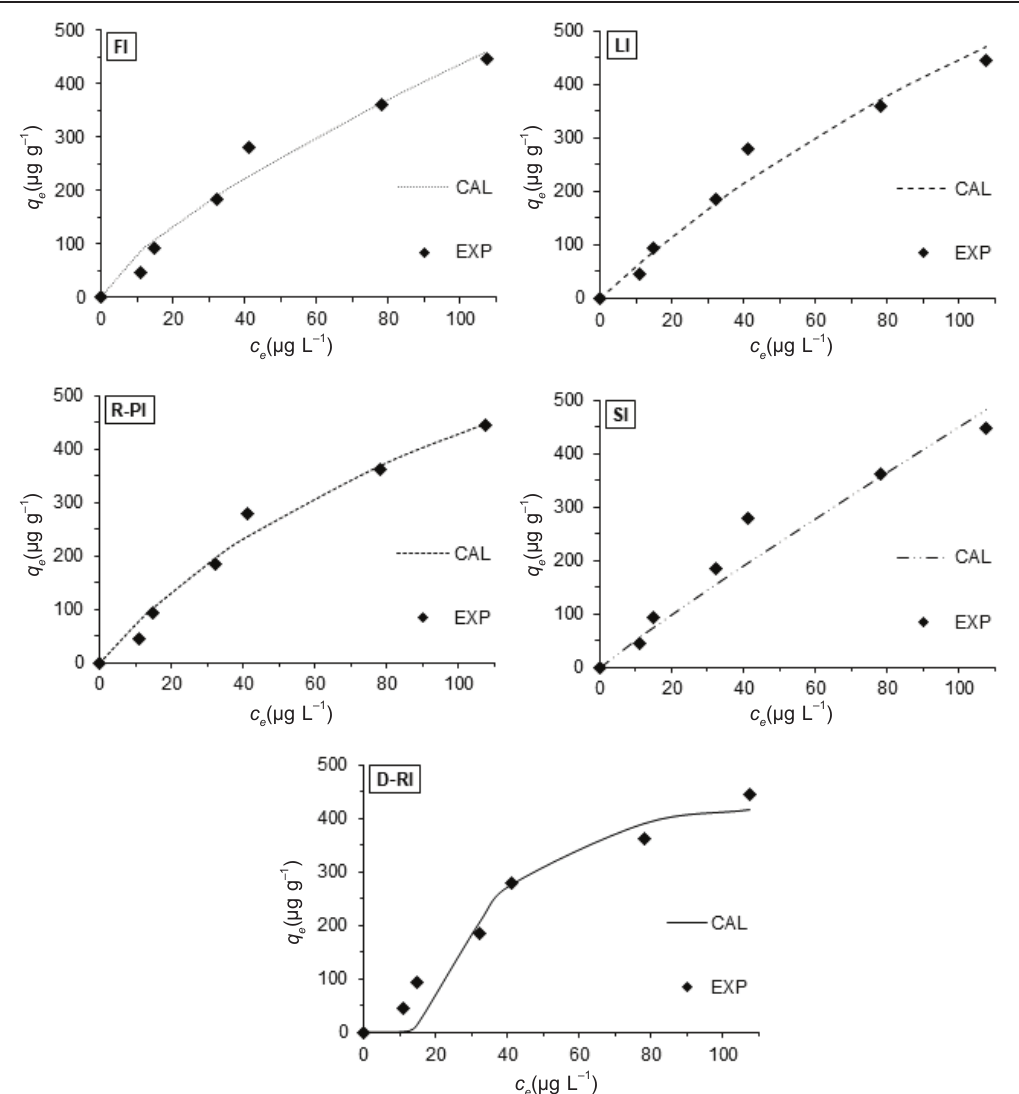
Fig. 3 – Modelled isotherm profiles of the adsorption of As(V) onto GFO (CAL – calculated values, EXP – experimental values) (As(V) concentration 0–1000 μg L −1 , volume of solution 0.1 L, contact time 120 min, amount of adsorbent 0.2 g, neutral pH, temperature 20±2 °C, agitation speed 150 rpm) Table 4 – Comparison of PFO and PSO models parameters for As(V) adsorption onto GFO (As(V) initial